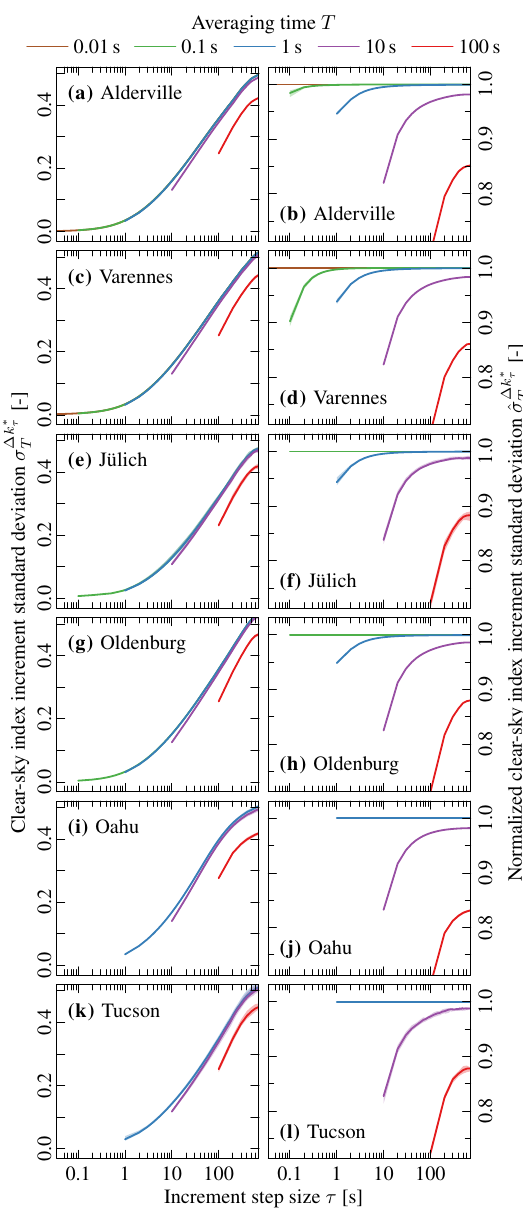
Figure 6. Structures of absolute clear-sky index standard deviation (cid:49)k ∗ τ σ T (left column), and its normalized counterpart umn) as functions of increment time τ for up to five orders of mag- nitude of averaging time T = 0 . 01, T = 0 . 1, T = 1, T = 10, and T = 100s under mixed-sky conditions for all six available loca- tions. The spread across individual single-sensor structures is indi- cated using semi-transparent coloring, while the solid lines are de- rived by averaging the single-sensor structures for each τ . In most cases, the spread is so small that it is indistinguishable from the multi-sensor